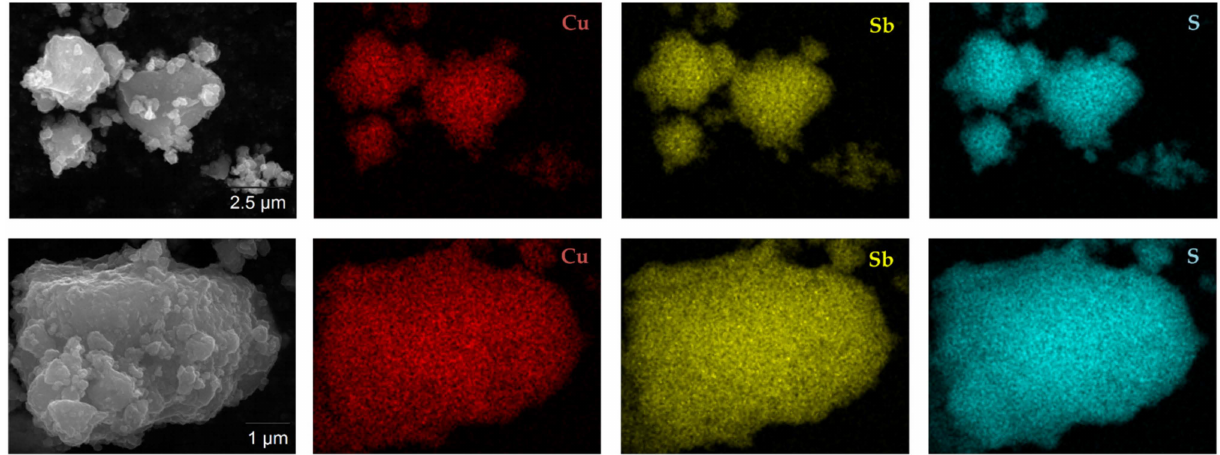
Figure 4. EDS elemental mapping for the CuSbS 2 powder particles directly produced by mechanochemical